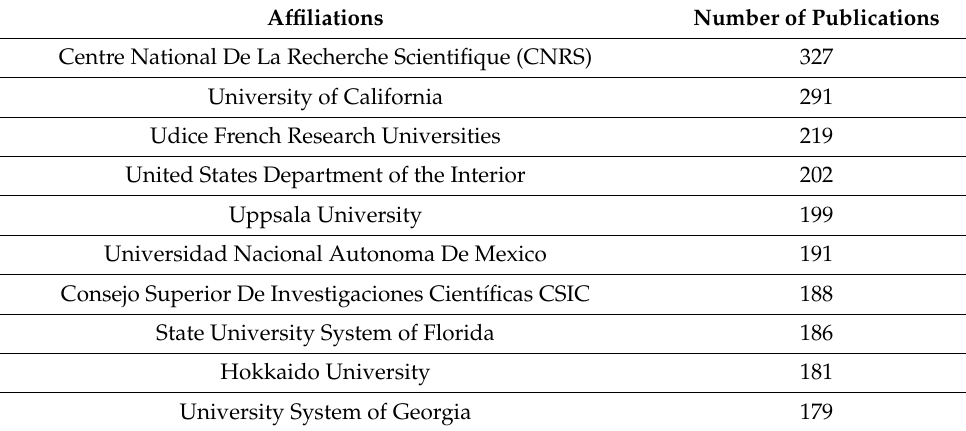
Table 2. Top 10 affiliations involved in crayfish research.